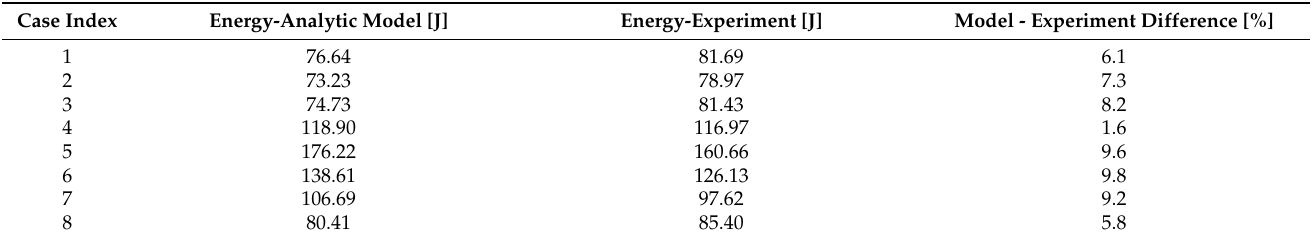
Figure 10. Results of the experimental verification of the specific energy consumption. The charts ( a – f ) show the instantaneous power consumption of all six robot’s motors. The green plot indicates instantaneous power of the model output; red plot indicates experimentally measured instantaneous power. Blue plot indicates the relative modelling error. Table 7. Comparison of the total modelled and total measured energy for 8 random